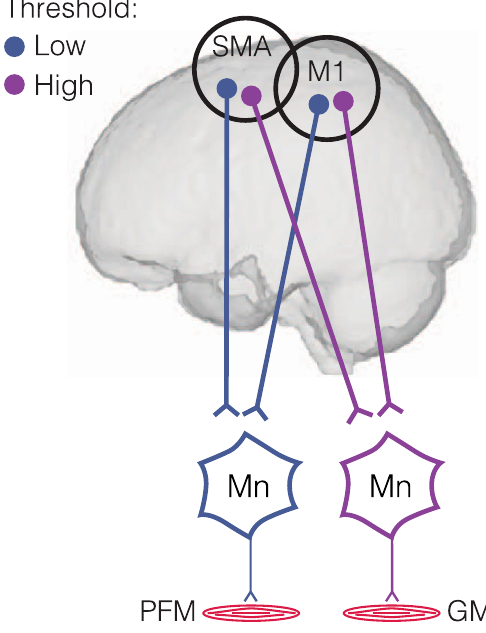
Figure 5. Schematic representation of proposed cortical representation of the human pelvic floor. We proposed that, similar to other muscles such as the gluteus maximus muscle (GMM), pelvic floor muscles (PFM) have a distributed representation in the supplementary motor area (SMA) and the primary motor cortex (M1). We further propose that the PFM representation has a lower activation threshold than synergistic muscles such as the GMM. This activation threshold difference may explain why the PFM is activated in advance of the synergists during cortically-driven activation. Mn = Motor